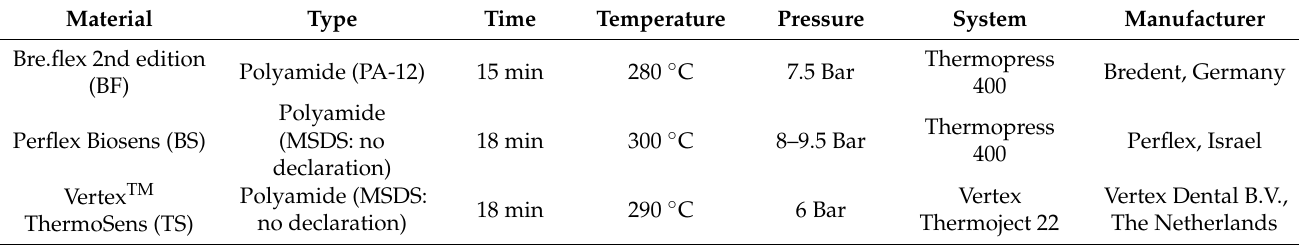
Table 1. Materials, type, manufacturer, and fabrication parameters included in the